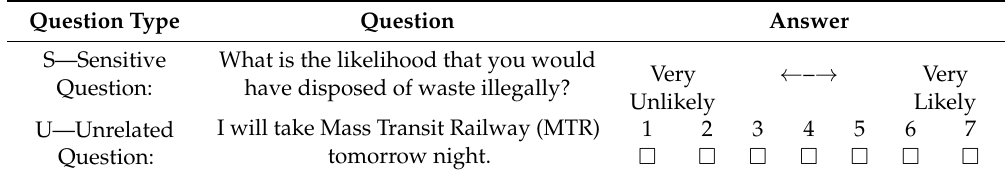
Table 3. Sample questions for assessing intention of illegal waste disposal using the